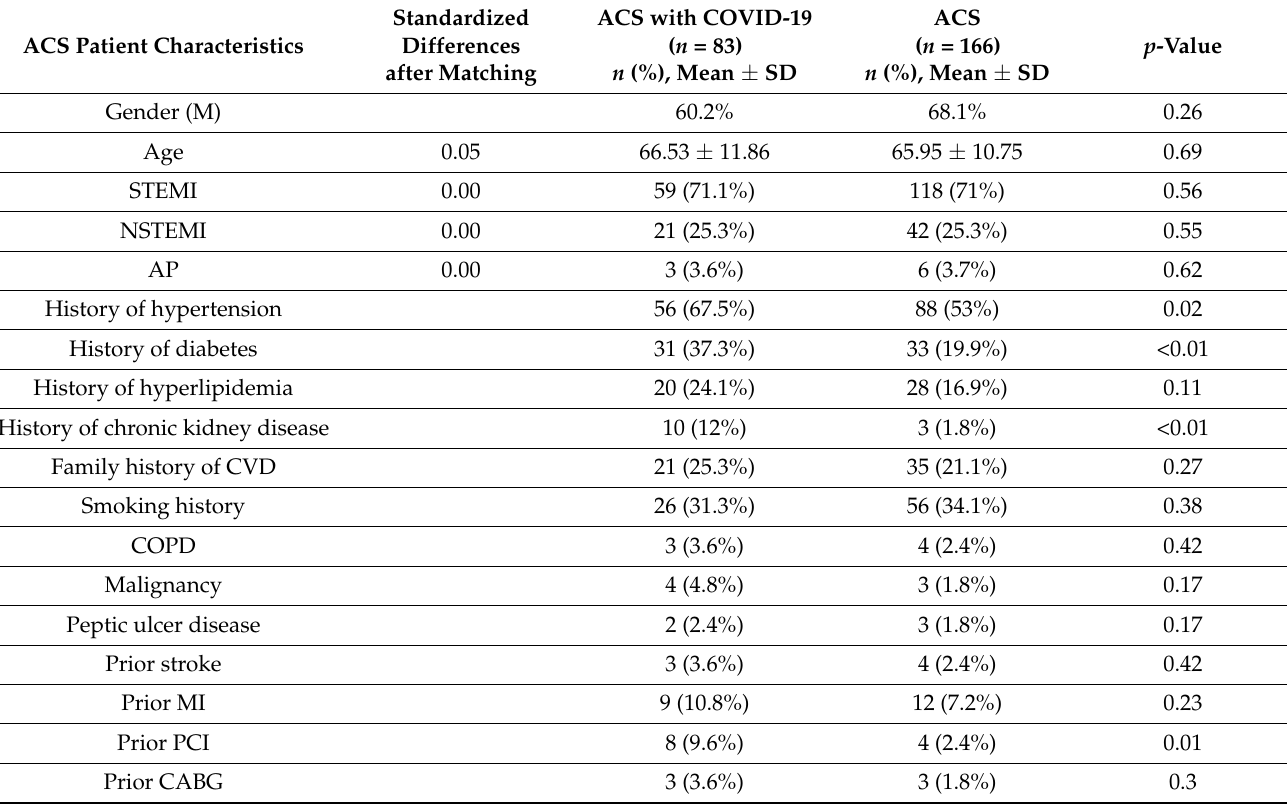
Table 1. Baseline characteristics, comorbidities, and risk